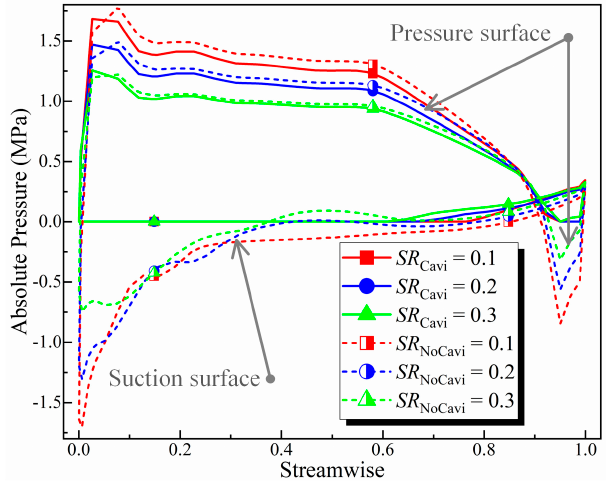
Figure 11. Comparison of the absolute pressure of stator blade surface between no cavitation and cavitation under various SR when N P = 3000 rpm.